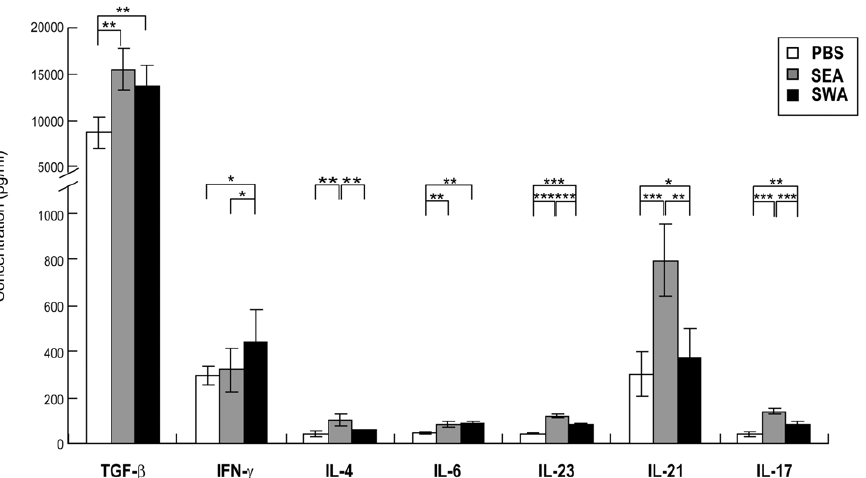
Figure 4. ELISA detection of cytokines in the supernatant produced by SEA or SWA immunized mice splenocytes. For each of three independent experiments, C57BL/6 mice (8 per group) were each injected subcutaneously in the back with 100 m l of an IFA emulsified solution containing 50 m g of SEA, 50 m g of SWA or PBS. The immunizations were repeated two times with a 14-day interval. Two weeks after the final vaccination, the mice were sacrificed, and single cell suspensions of splenocytes were prepared. The splenocytes (2 6 10 5 /well in 200 m l complete media) were cultured in 96 well plates with PMA/ionomycin. Culture supernatants were collected after 72 h, and cytokines were detected by ELISA. Results are expressed as mean 6 SD of 24 mice from three independent experiments. * P , 0.05; ** P , 0.01; *** P , 0.001, compared to control groups as indicated.